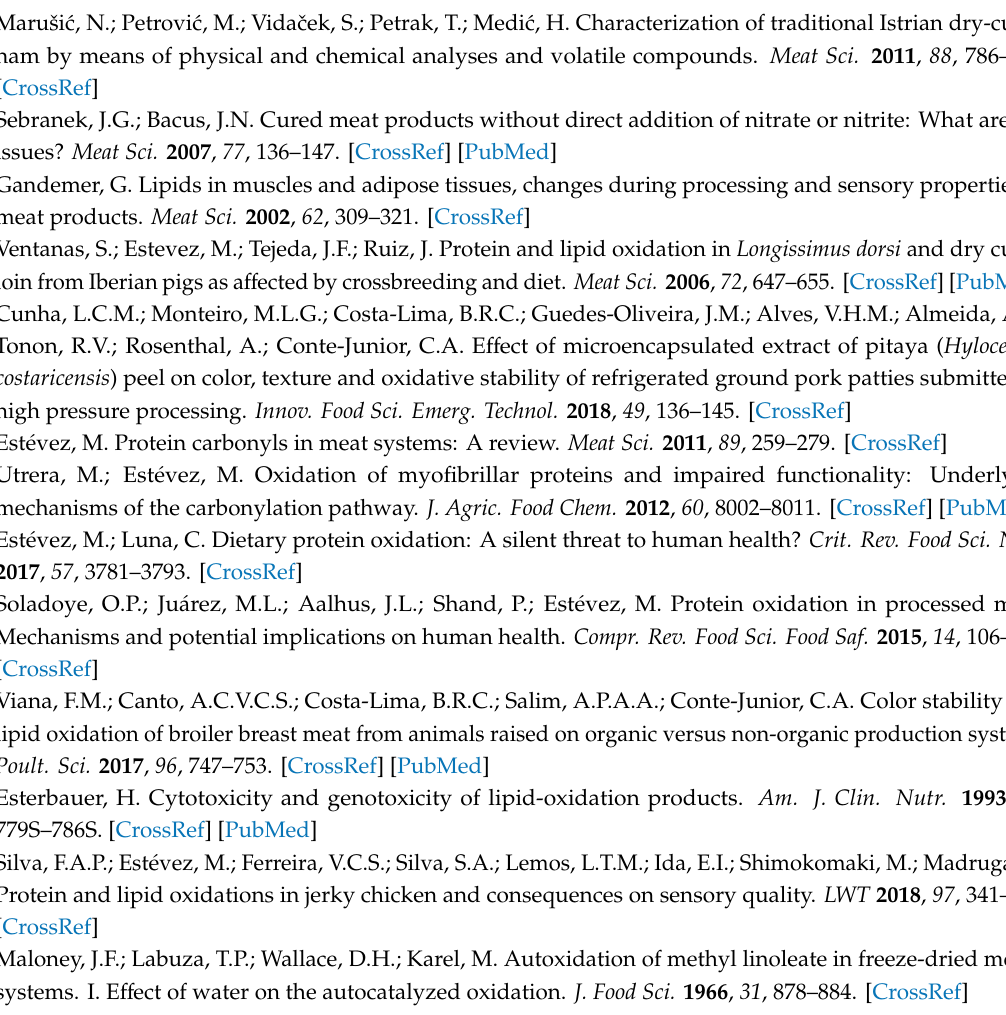
Table S1: Overall correlation between significative physicochemical characteristics (cluster analysis) on Brazilian dry-cured